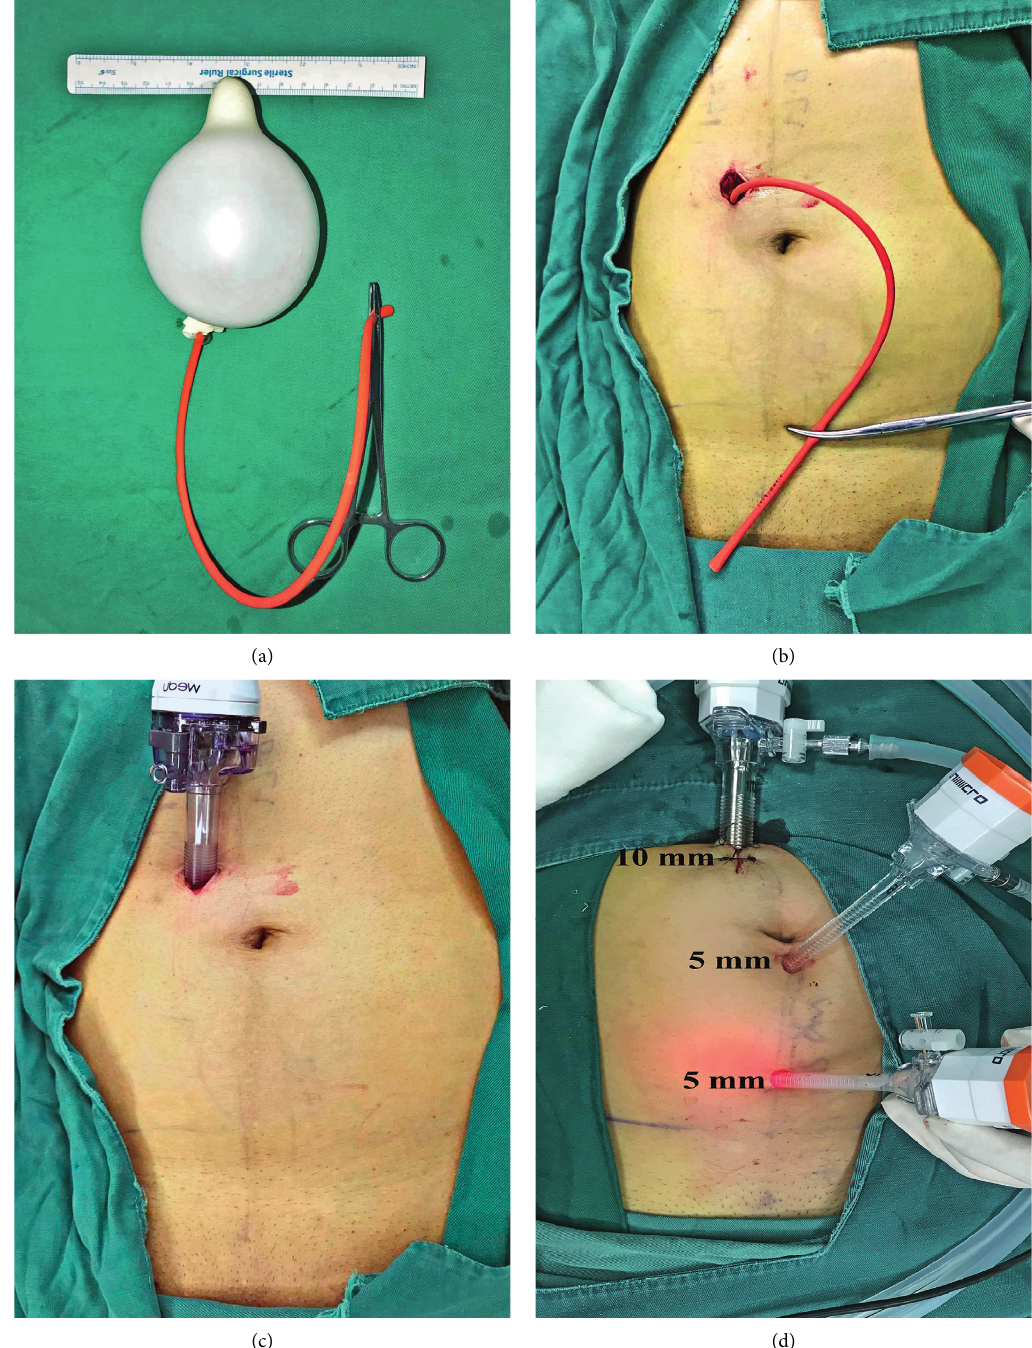
Figure 1: Incision, dissection of retromuscular space with handmade balloon and placement of trocars. (a) A handmade balloon which was made of a finger of glove tied to a small tube. (b) The retromuscular space was insufflated about 150ml of air with a syringe. (c) A 10mm trocar was inserted through incision. (d) Two other 5mm trocars were